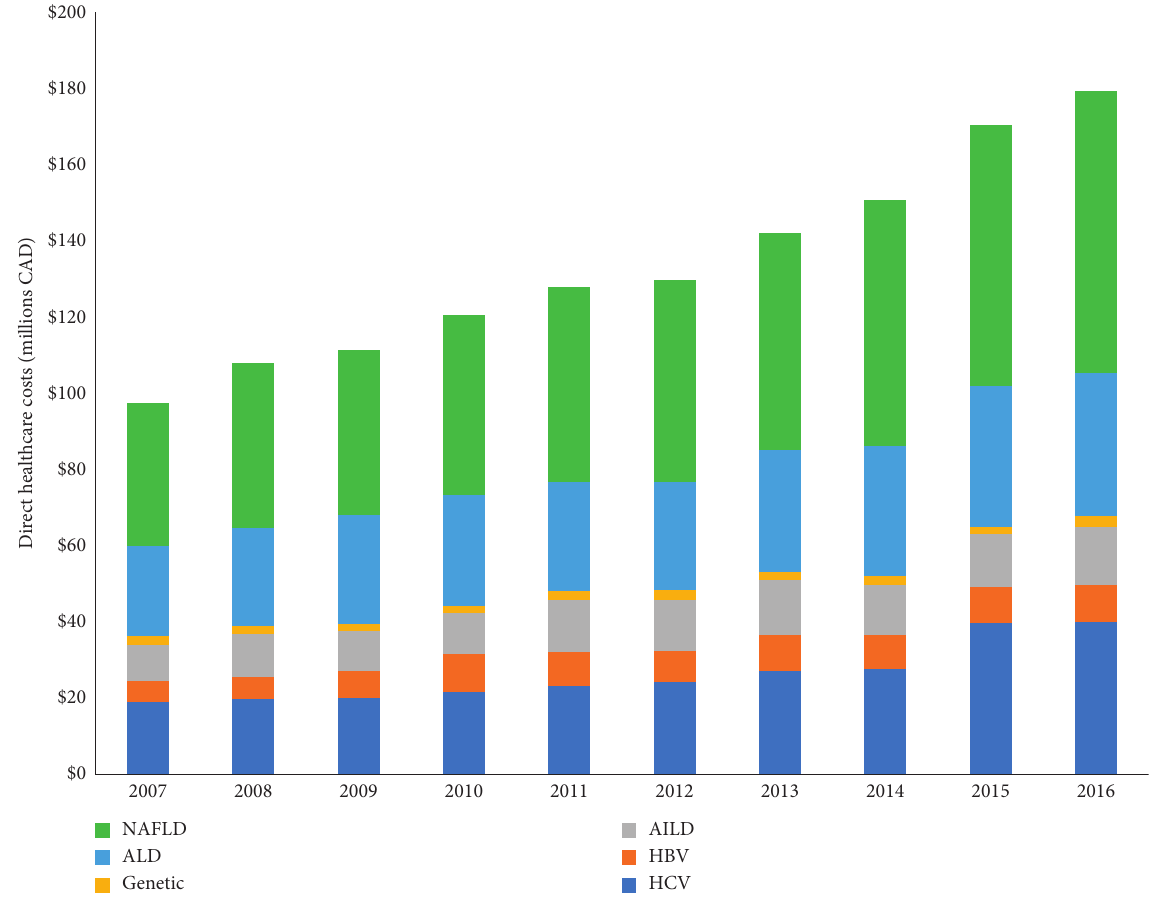
Figure 3: Overall direct healthcare costs in young adults with cirrhosis in Ontario 2007-2016. NAFLD: nonalcoholic fatty liver disease; HCV: hepatitis C; ALD: alcohol-associated liver disease; HBV: hepatitis B; AILD: autoimmune liver